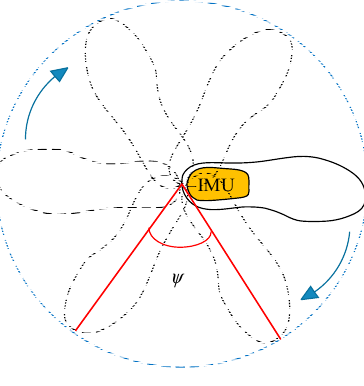
Figure 2. Sketch picture of magnetometer calibration.